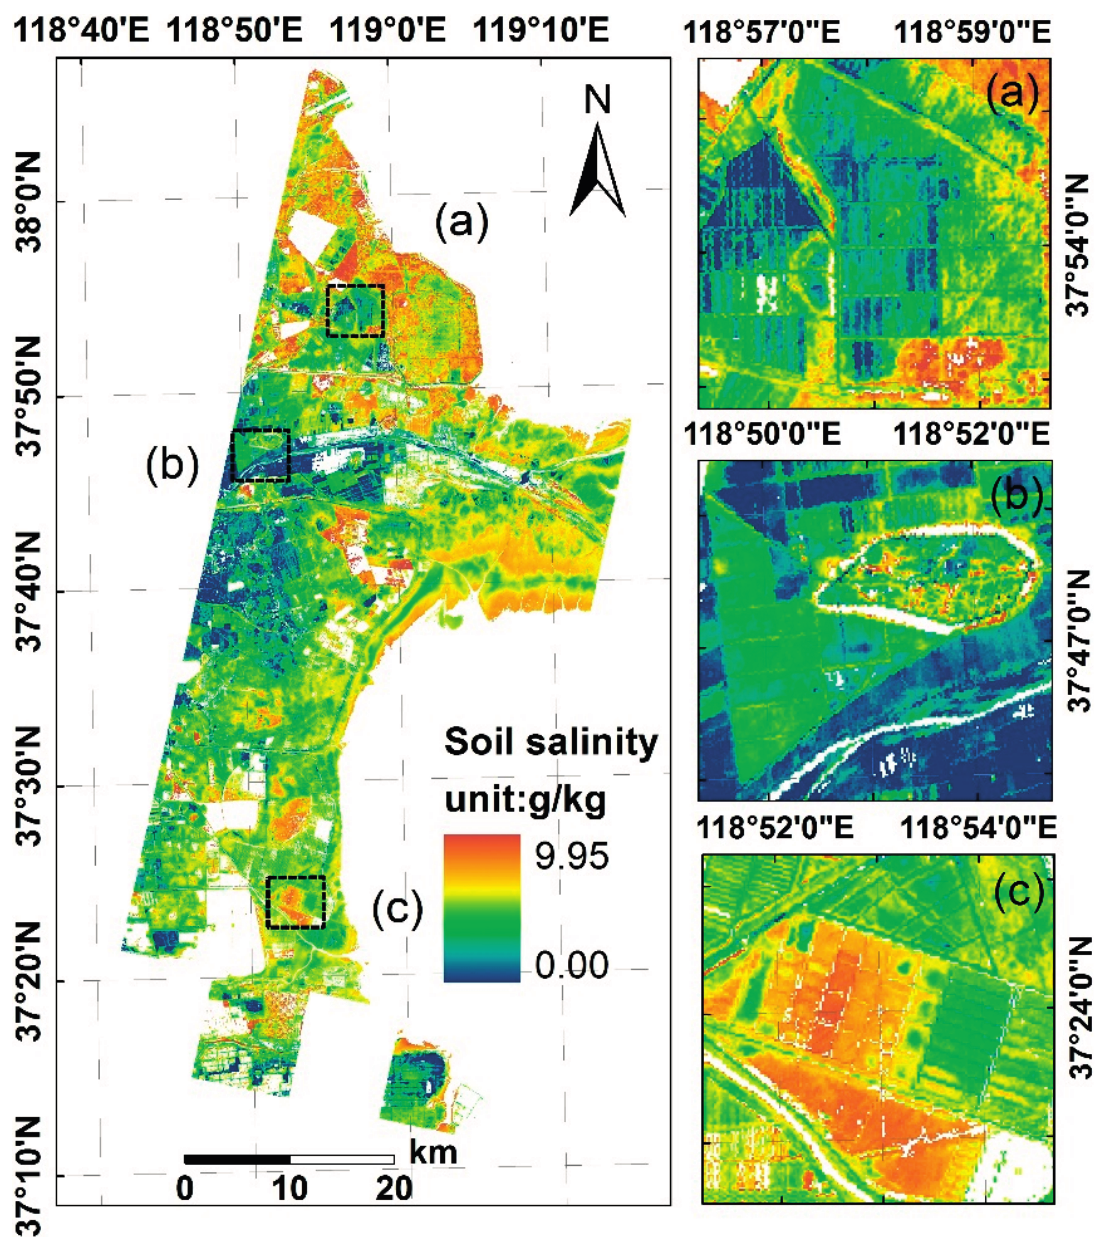
Figure 7. Soil salinity map over study area and detailed soil salinity distribution at three agricultural lands in the north with slight-moderately saline soils ( a ); along the Yellow River with non-saline and slightly saline soils ( b ) and in the south with moderate-to-highly saline soils ( c